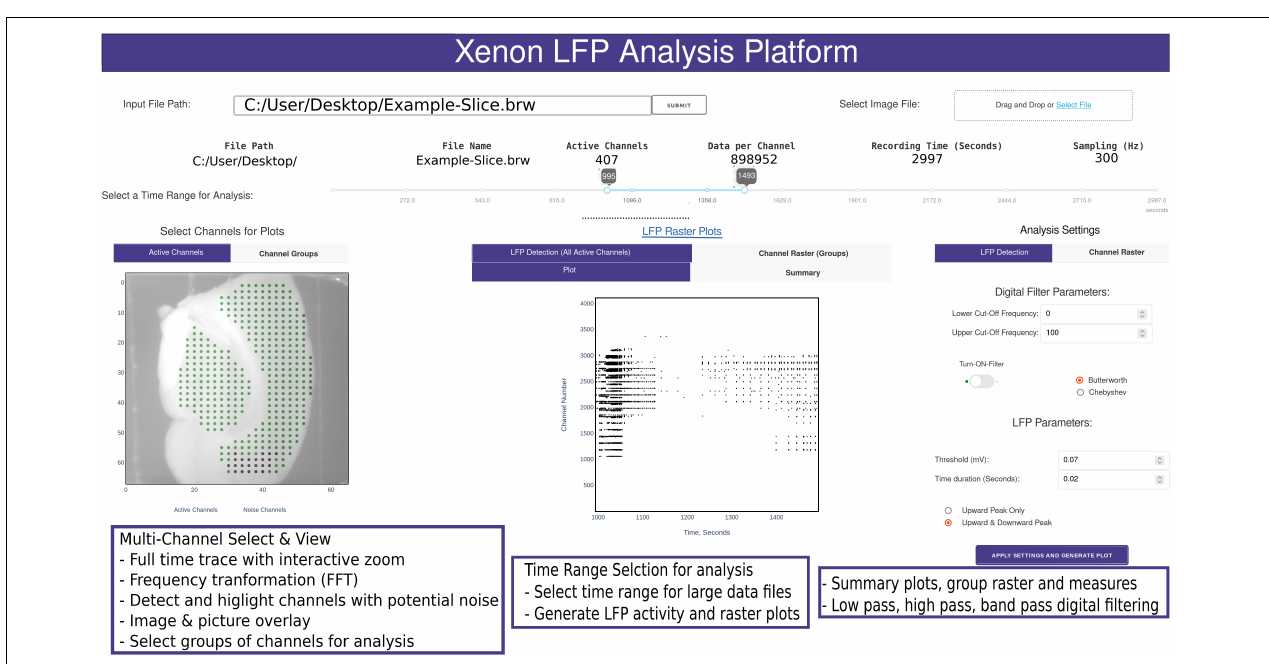
FIGURE 2 | Snapshot of the analysis GUI features. A view of the analysis GUI which is rendered in an html browser built in Python using Plotly’s Dash. The GUI has several interactive features from individual and group channel selection, low-pass, high-pass, and band-pass filtering, viewing entire trace or a small section of the trace, Fast Fourier Transformation (FFT) of sections from selected traces, customized raster plots, small groups of channels, and generation of group summary